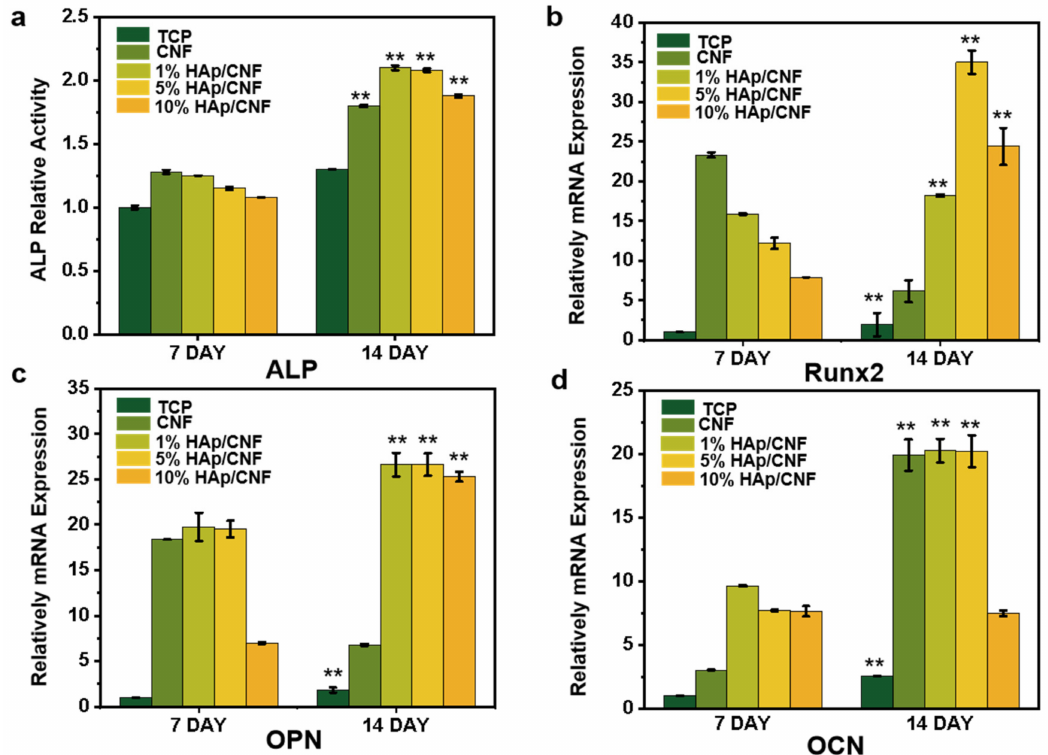
Figure 4. Biochemical markers of osteogenic differentiation of h-ADSCs cultured on CNF and HAp/CNF membranes. ( a ) Alkaline phosphatase (ALP) activity in extracts of h-ADSCs on days 7 and 14 of culturing on the noted materials. ( b ) Runt-related transcription factor 2 ( RUNX2 ), ( c ) osteopontin ( OPN ), and ( d ) osteocalcin ( OCN ). All data are shown as means ± standard deviation (n = 3). ** p <